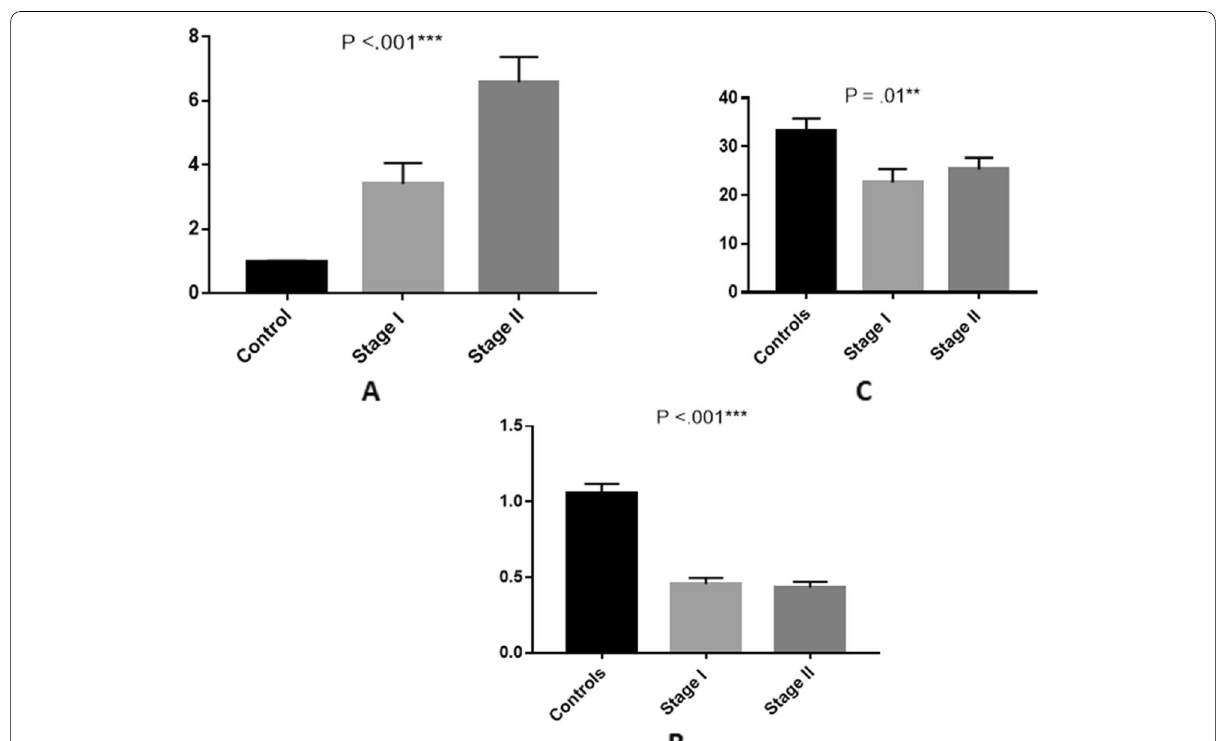
Fig. 2 A Showed the mean SE of tissue PDL‑1 expression levels in controls and stages I and II of lung cancer. B The mean ± expression levels in controls and stages I and II of lung cancer. C The mean